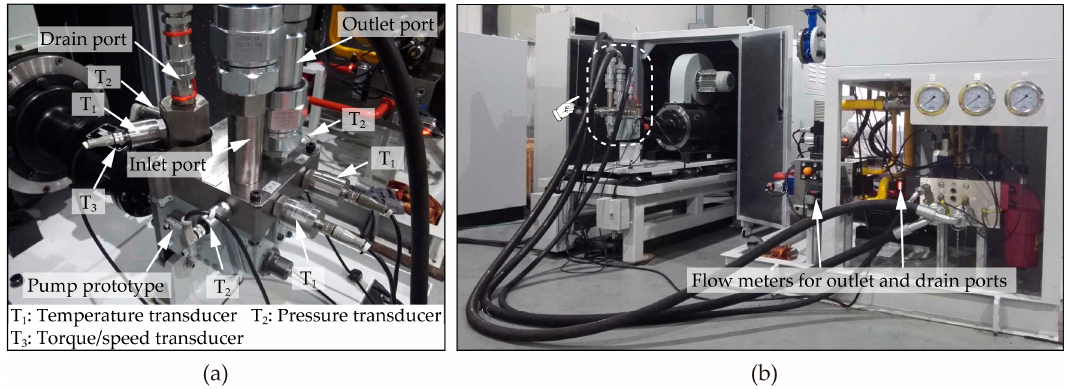
Figure 5. Experiments on the pump prototype: ( a ) Transducers installed in the pump prototype; ( b ) Test rig for the pump prototype.